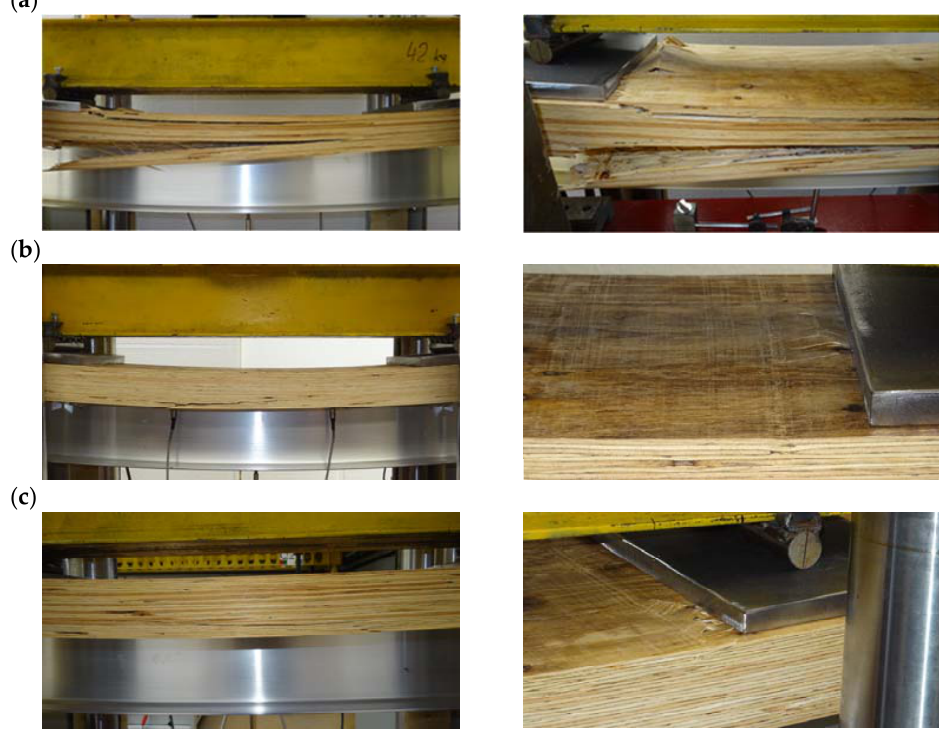
Figure 12. Failure modes of the aluminium–timber composite beams: B120 ( a ), B160 ( b ), B200 ( c